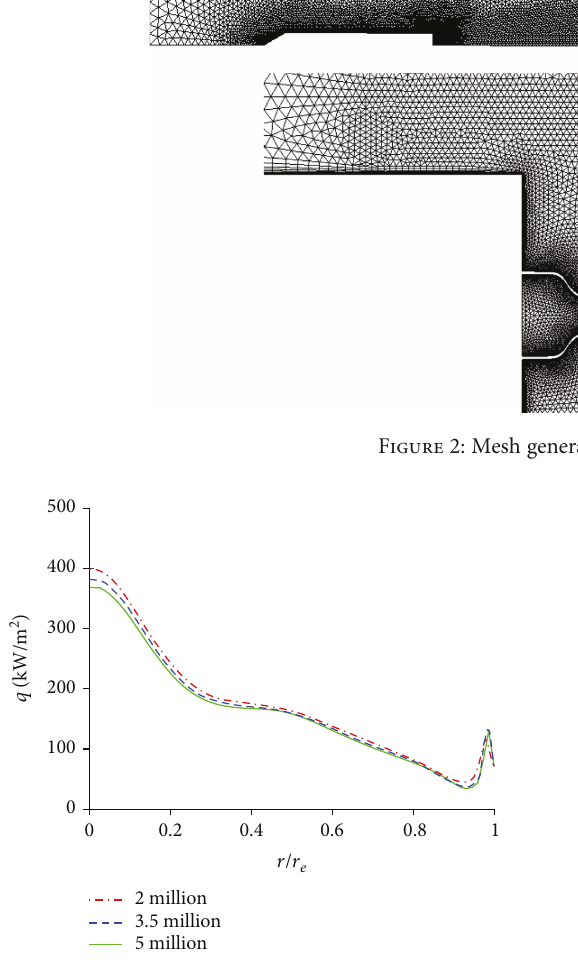
Figure 3: Grid convergence veri fi